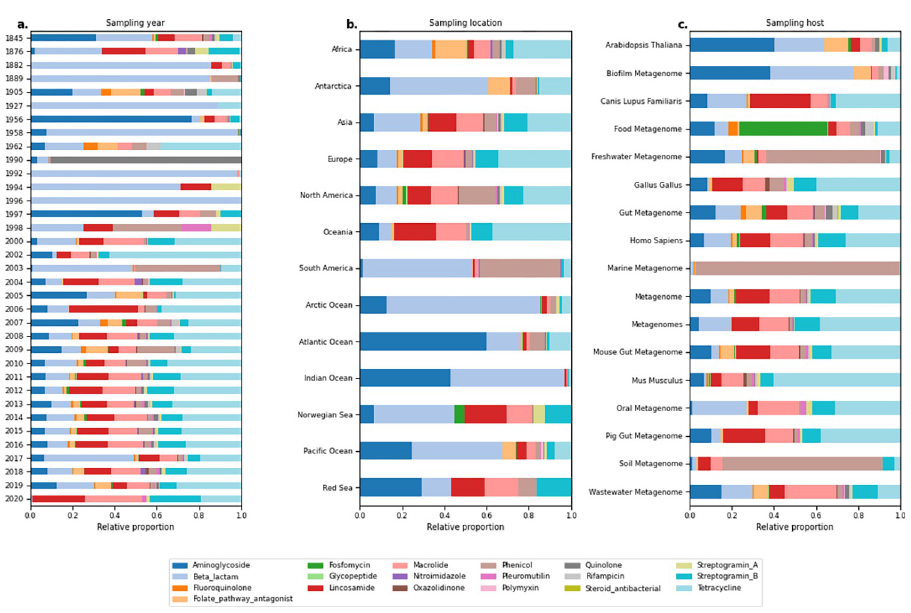
Fig 4. Composition of reads assigned to ARGs from different resistance classes grouped by sampling origin. (a) Grouped by sampling year. ( b) Grouped per sampling location. ( c) Grouped per sampling host. Only hosts with more than 1,000 metagenomes analyzed are shown. The data underlying this figure can be found at https://doi.org/10.5281/ zenodo.6919377.